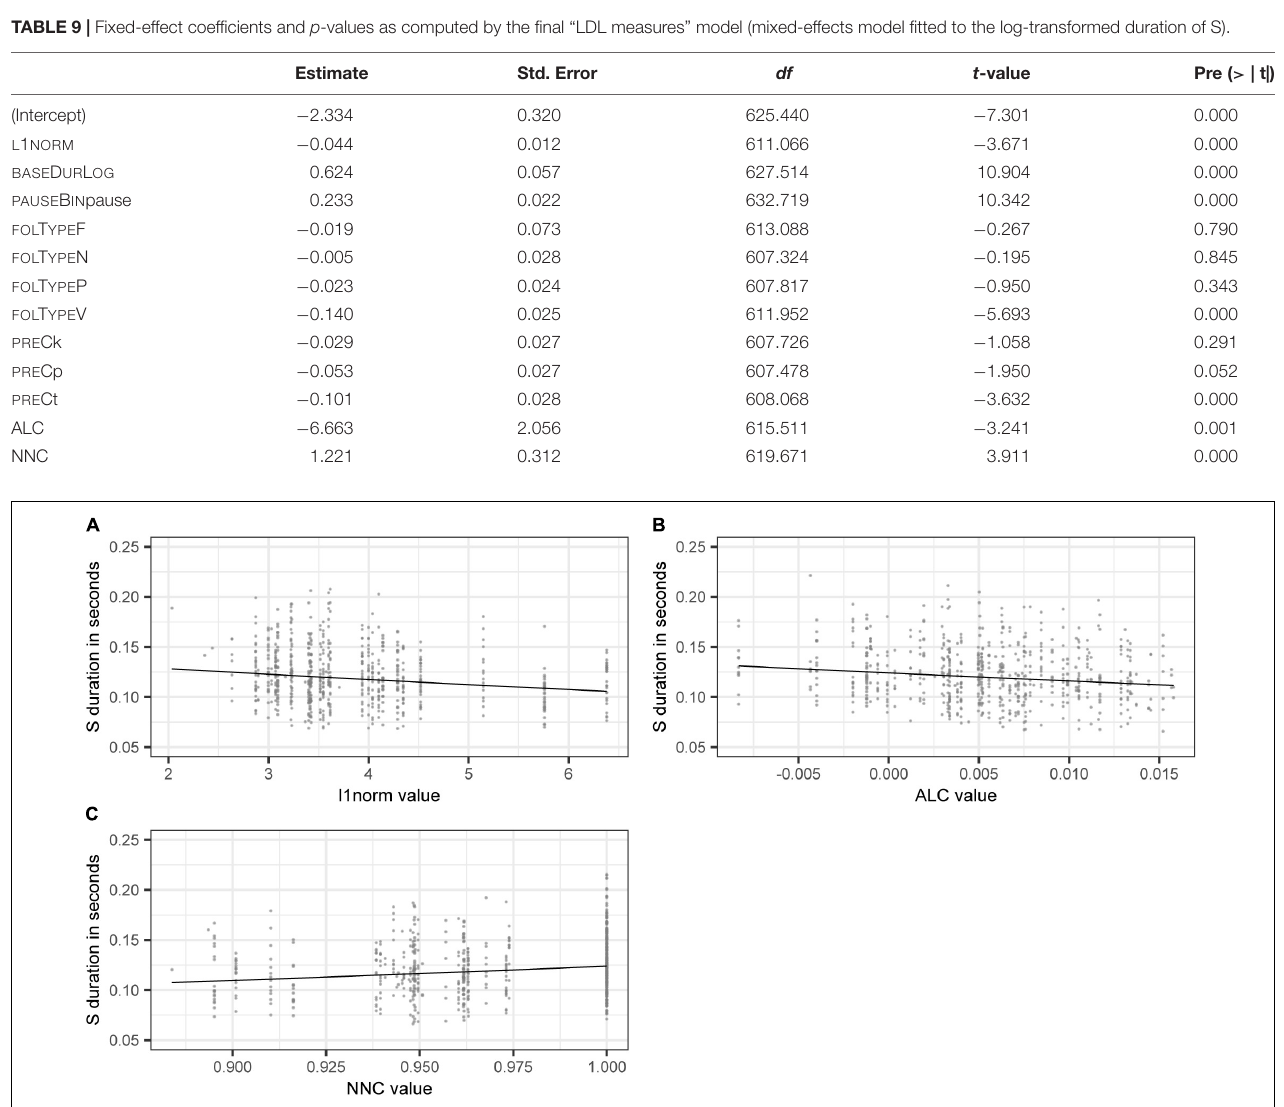
TABLE 9 | Fixed-effect coefficients and p -values as computed by the final “LDL measures” model (mixed-effects model fitted to the log-transformed duration of S). Estimate Std. Error